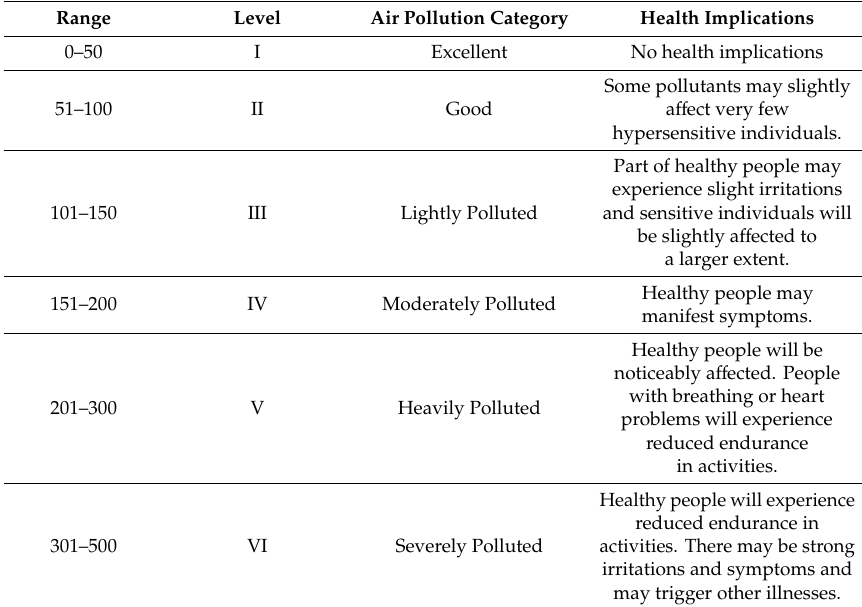
Table 1. Ranges of the air quality index (AQI) and the corresponding air pollution